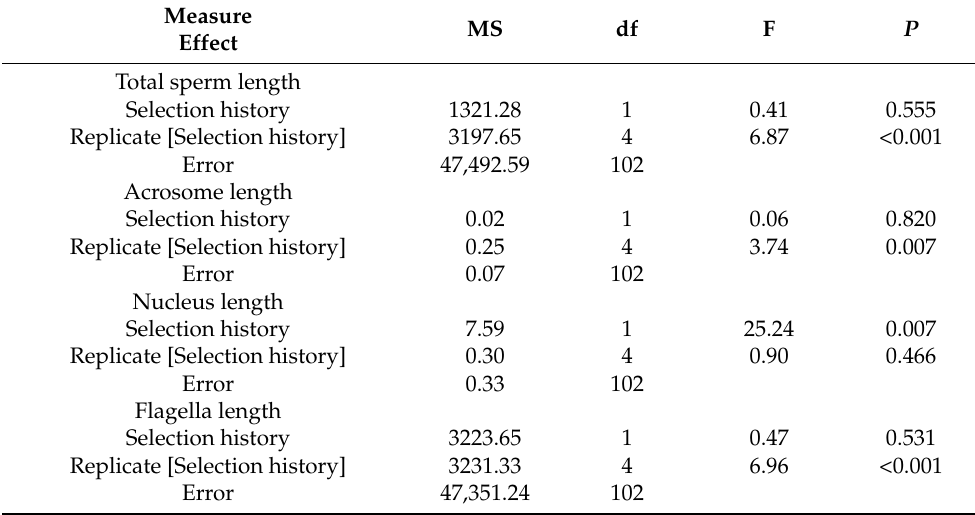
Table 1. Nested analyses of variance in sperm cell components and total sperm length, across 20 generations of three replicate lines of Onthophagus taurus subjected to sexual selection and three replicate lines subjected to enforced monogamy. Bonferroni adjusted critical P 0.05 = 0.013 for four related